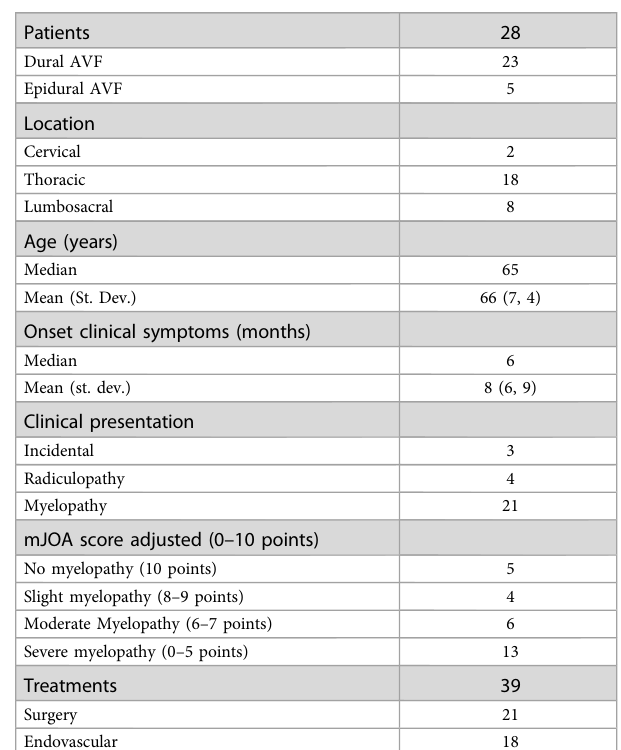
TABLE 1 Patient ’ s